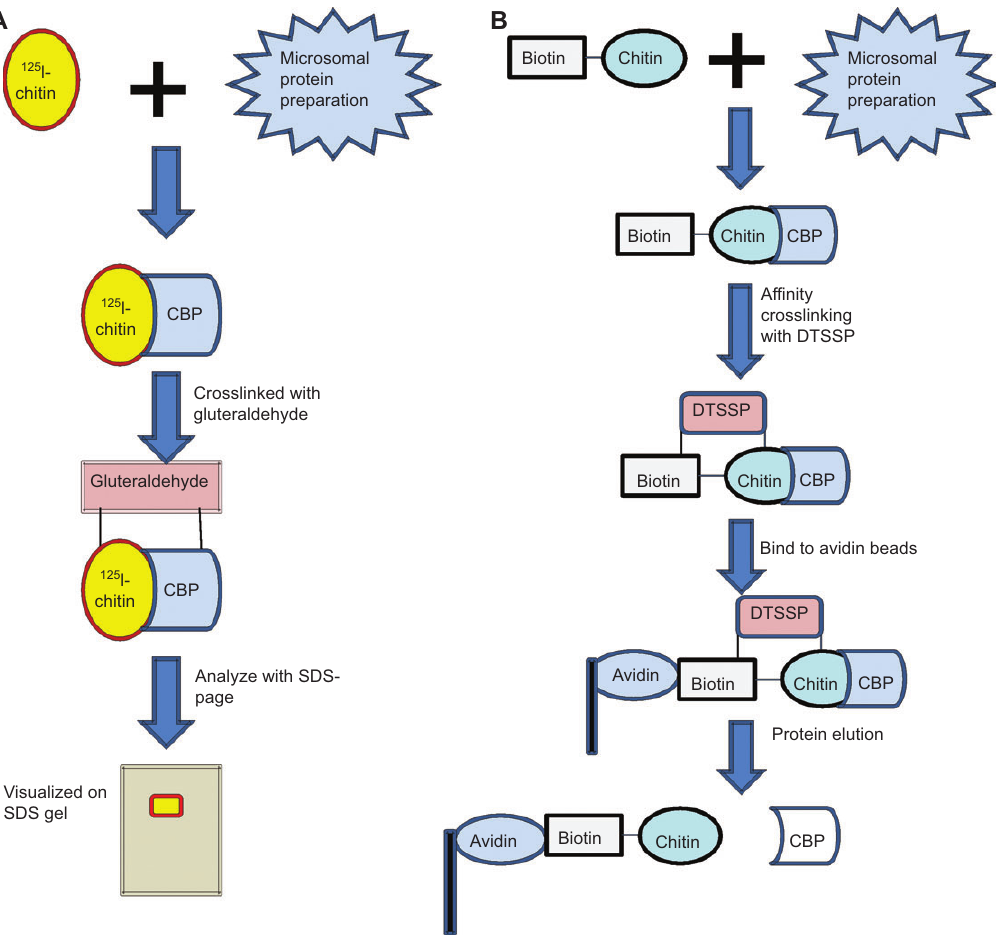
Figure 4 Affinity binding assays. (A) Schematic of radiolabeled binding assay. 125 I-chitin incubated with microsomal membrane preparation can be used to measure chitin binding to chitin-binding proteins (CBP) in the microsomal membrane preparation. After ligand addition, the chitin-CBP complex is crosslinked with glutaraldehyde. The chitin binding protein can be detected by visualization with SDS-PAGE. (B) Purification of CBPs with biotinylated chitin. When biotinylated chitin is incubated with membrane preparation, biotinyl chitin binds to CBP. The protein-ligand complex is then crosslinked with DTSSP. The chitin-protein complex can be recovered by passage over a column containing avidin beads. The CBP is then eluted and subjected to further analysis, such as mass